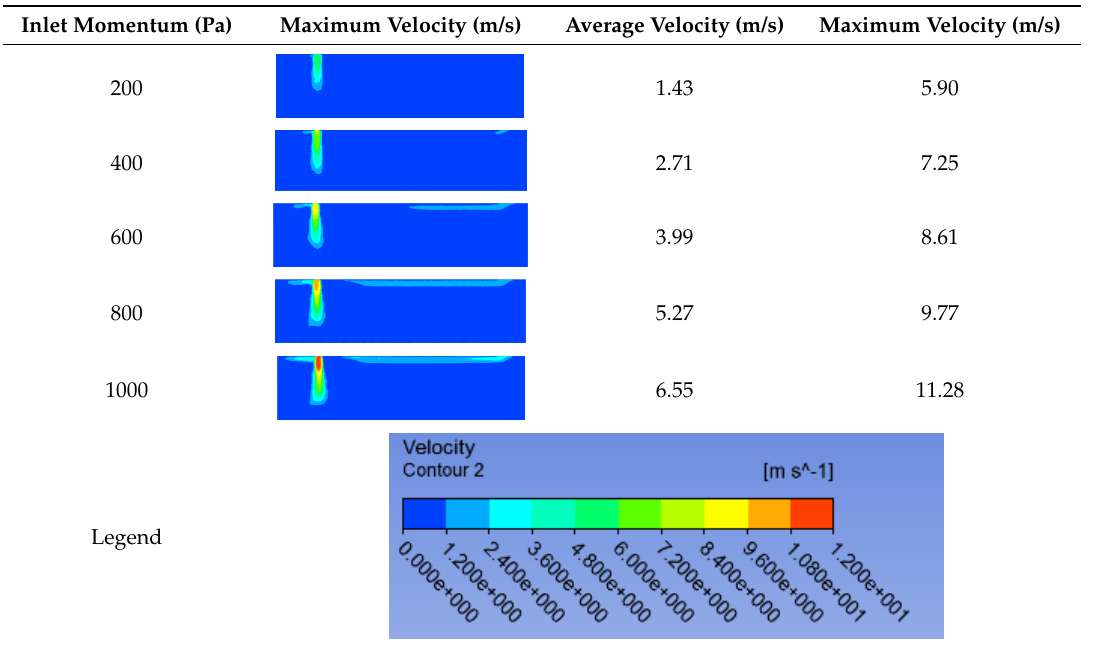
Table 4. Velocity contour of the inlet velocity due to slug flow.